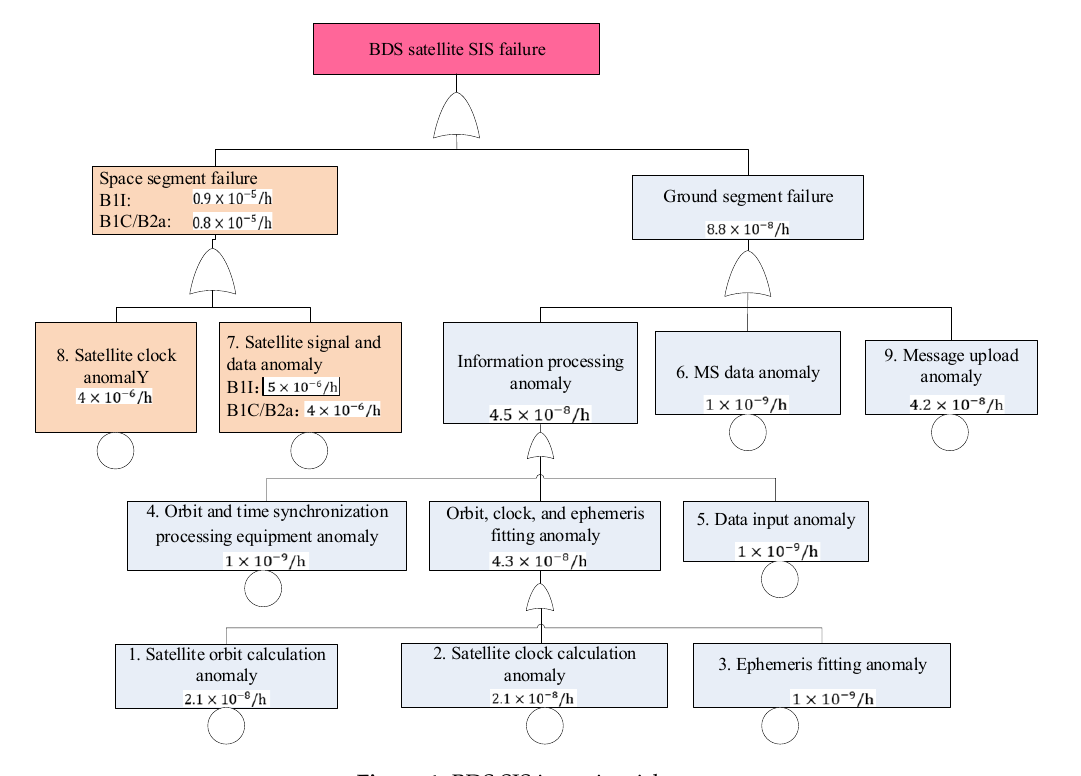
Figure 1. BDS SIS integrity risk tree.